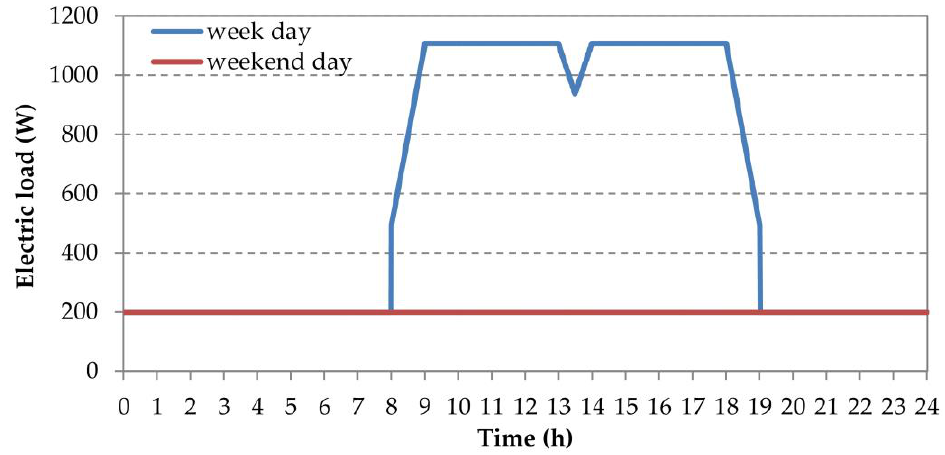
Figure 2. Electric load profile for each floor.